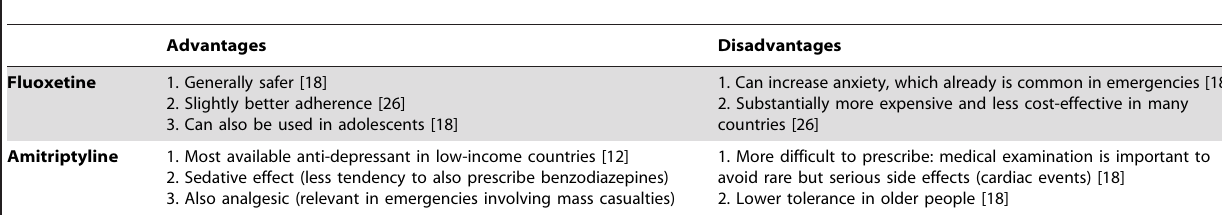
Table 3. Advantages and disadvantages of including fluoxetine versus amitriptyline in the Interagency Emergency Health Kit